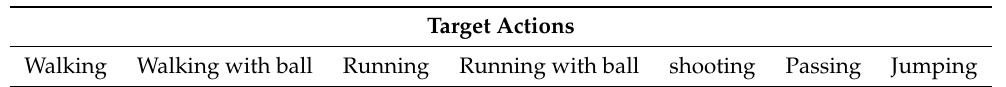
Table 1. Target Actions.